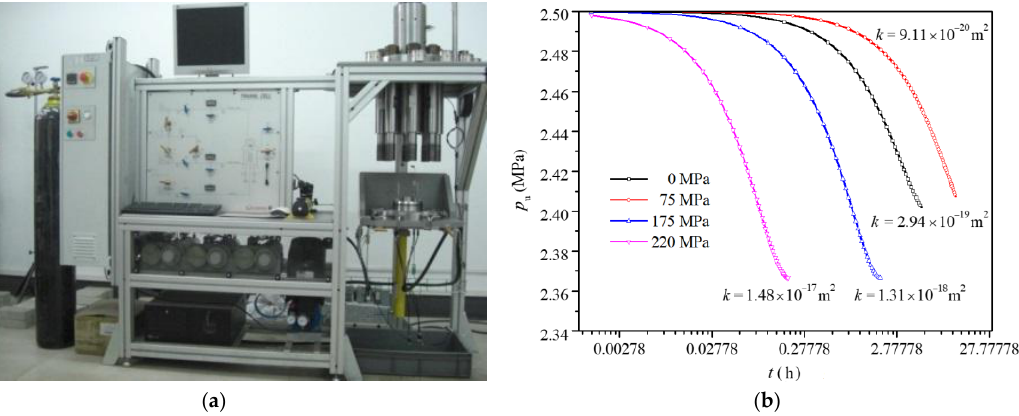
Figure 2. Coupled triaxial compression and two-phase flow testing system for low permeable rocks [34]: ( a ) Experimental facility by Research & Development; ( b ) Tested curves as an example.